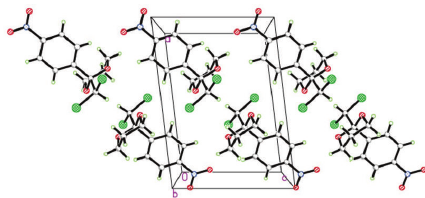
Figure 2: The packing view of compound 4 .